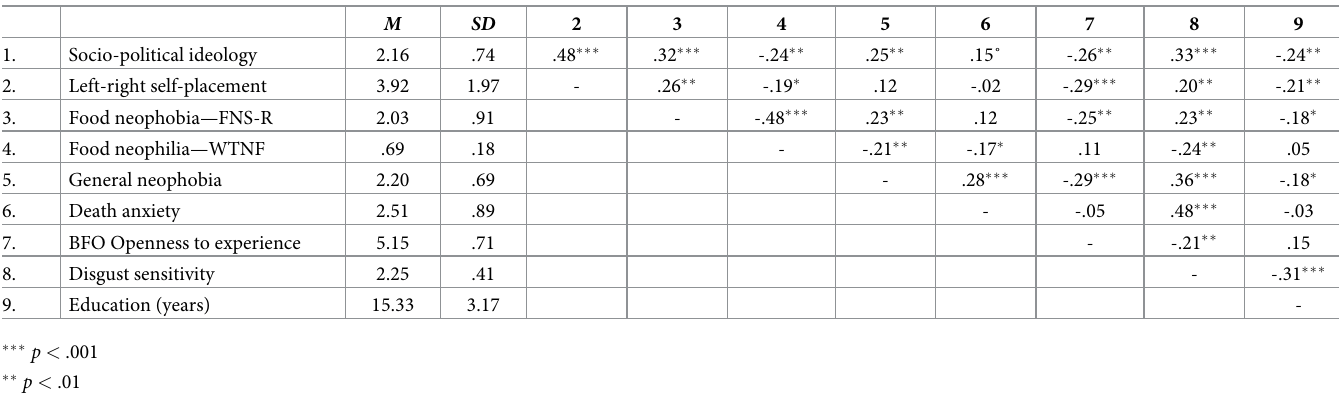
Table 1. Descriptives and correlations for Study 1